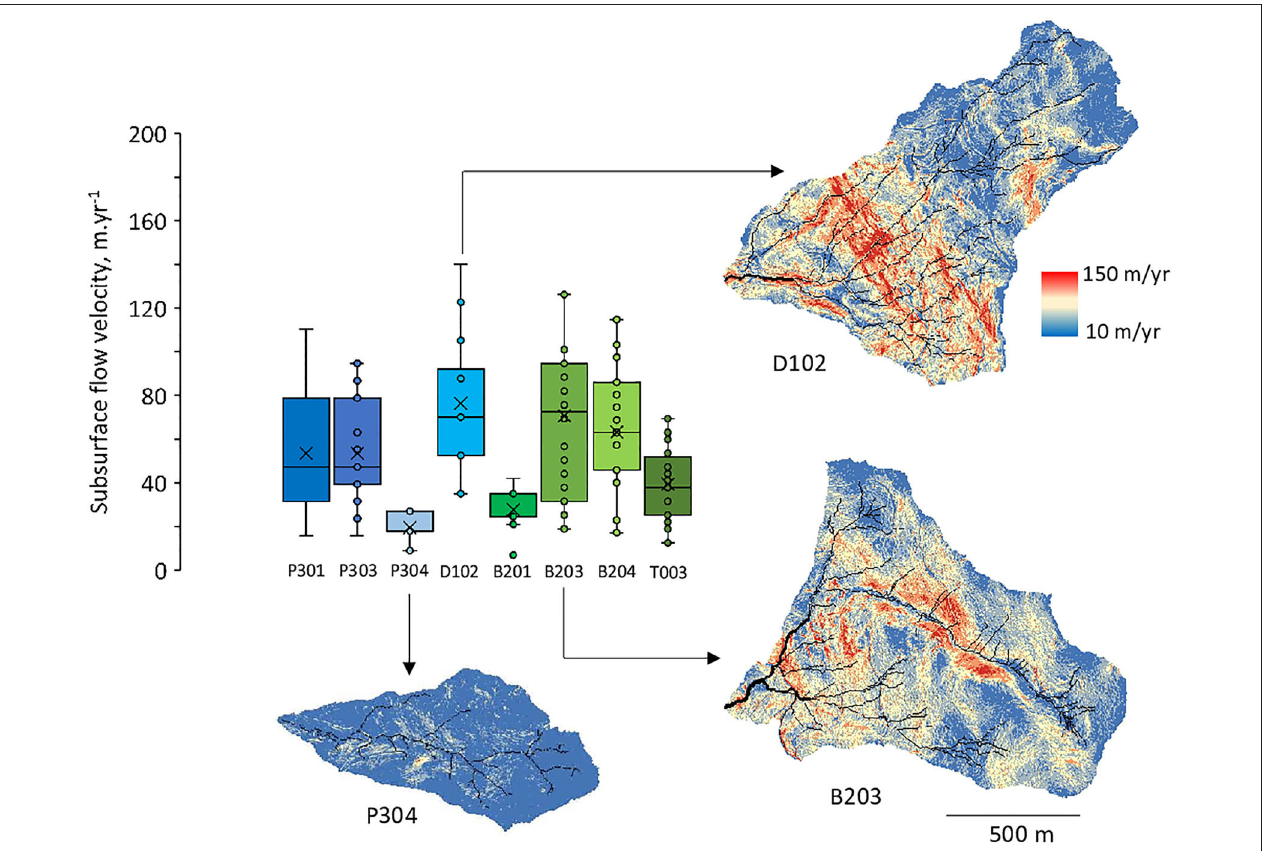
FIGURE 8 | Distribution of the simulated subsurface flow velocities along the flow lines. The distribution is shown for average hydrologic conditions. Illustrations are provided for three watersheds: P304, D102, and B203. The color scale is identical for all the watersheds to highlight the contrast between sites.